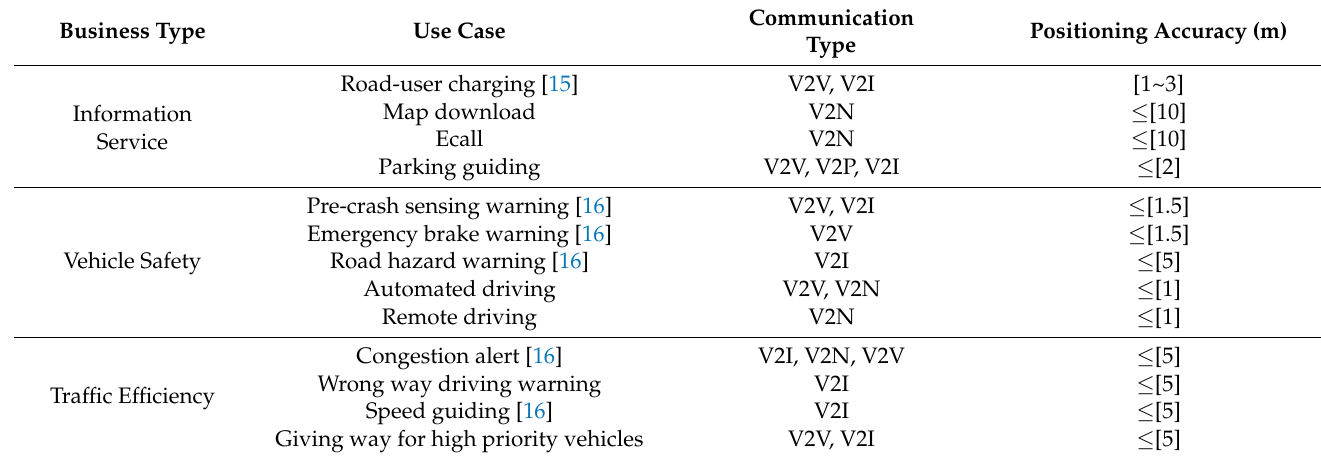
Table 1. Positioning accuracy requirements in different use